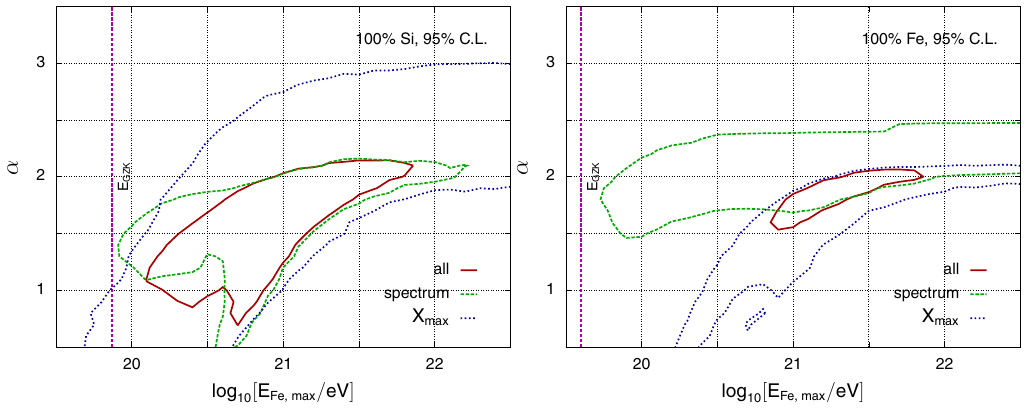
Figure 4. The 95% C.L. contour plots for silicon and iron only source compositions. These contours indicate the regions of spectral index/maximum energy parameter space where good-fits can be found to the PAO spectral and composition